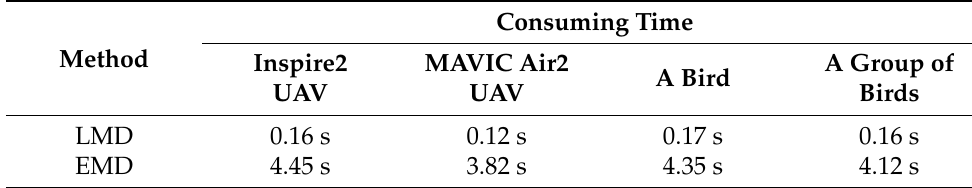
Table 4. Time consumed by m-DS components separation.